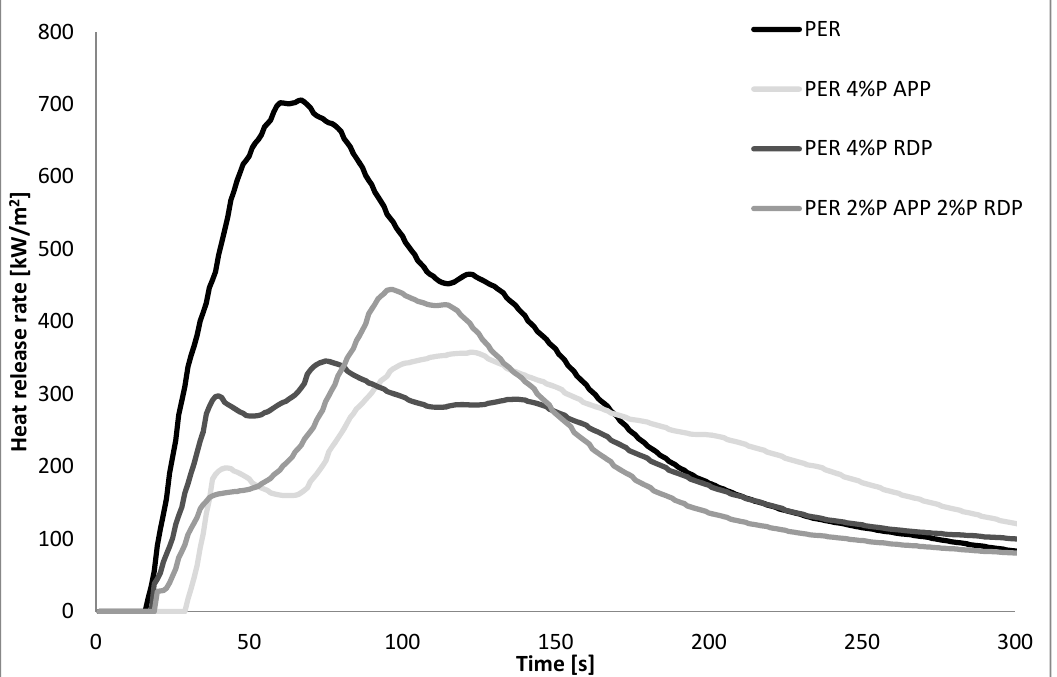
Figure 3. The heat release rate of the reference and flame retarded PER matrices.